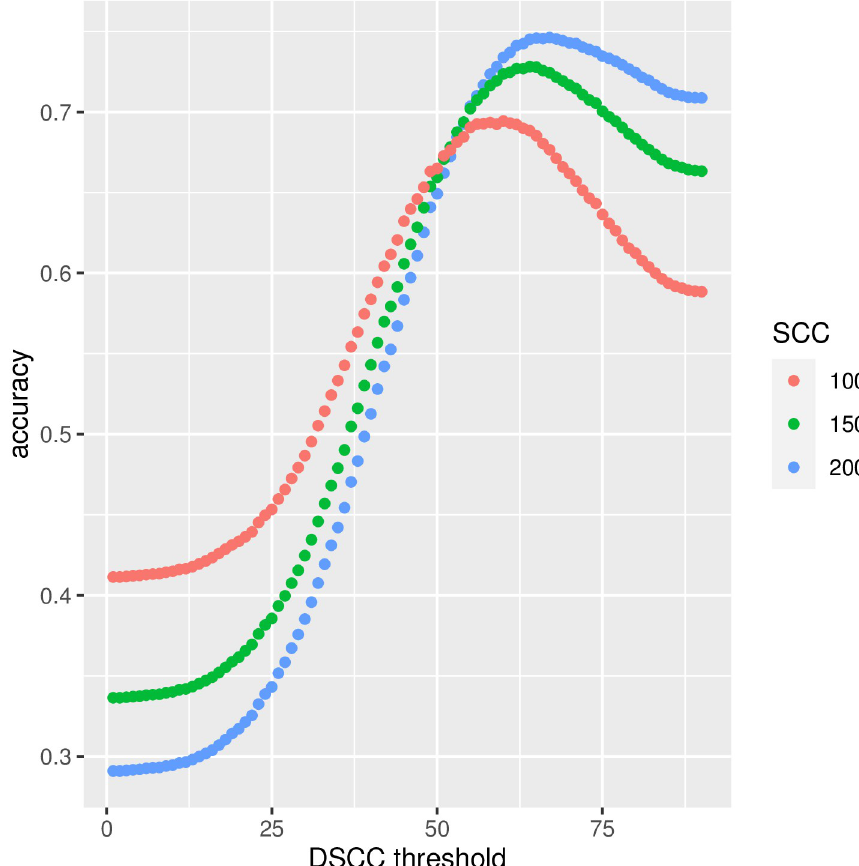
Fig 3. SCC vs DSCC for IMI detection. Total correct predictions (subclinical mastitis: yes or no) based on DSCC values. Subclinical mastitis to be predicted was defined based on three different SCC thresholds: > 200k, > 150k, >